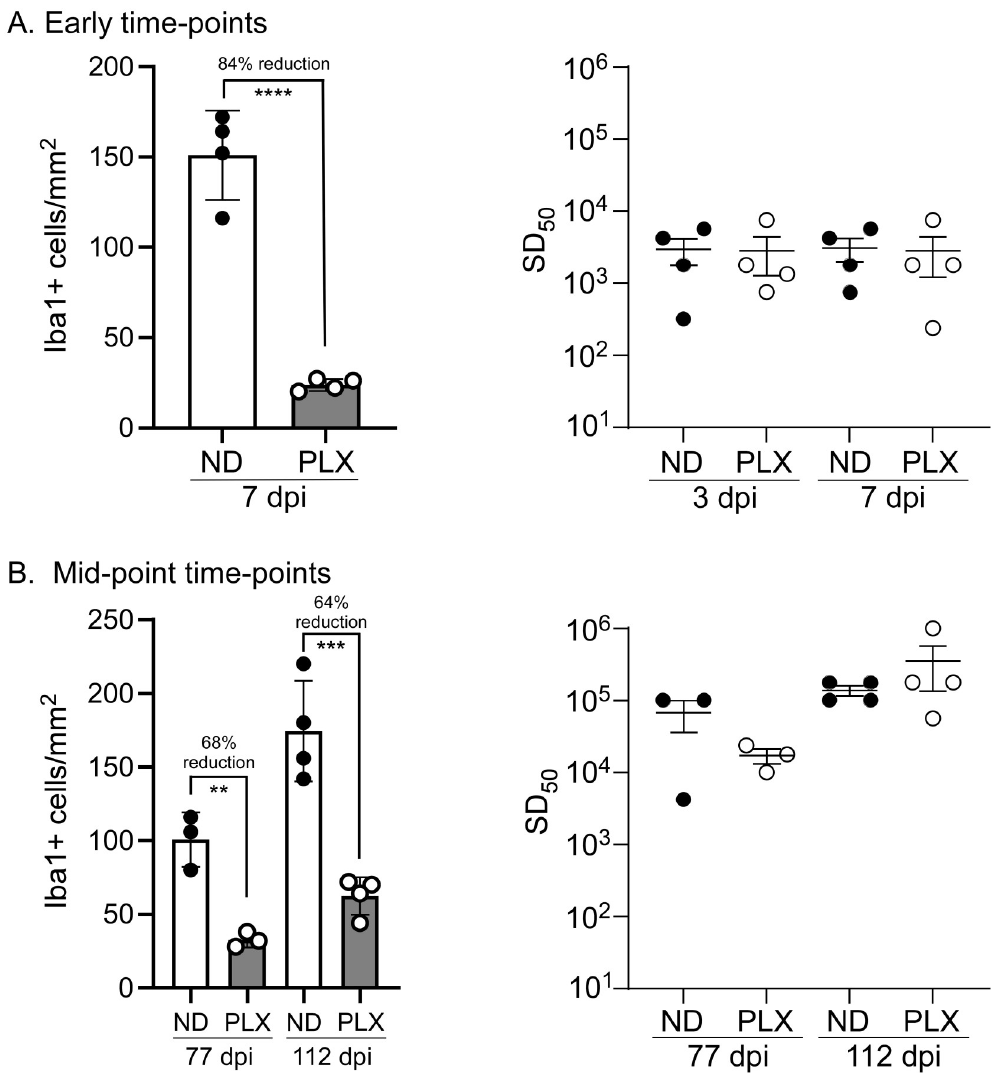
Fig 3. Microglial depletion and RT-QuIC seeding dose determination at mid-points of infection. Mice were treated with PLX5622 at day -7 and discontinued at day 3 or 7 (panel A) or discontinued at day 77 or 112 (panel B) when mice were euthanized for analysis. Sections of cortex were stained for Iba1, and positive cells were counted manually (panels A and B, left graphs). Solid circles indicate the number of Iba1+ cells in individual mice with no drug (ND) and the white column is the mean. Open circles indicate the number of Iba1+ cells in individual mice treated with PLX5622 (PLX) and the grey column indicates the mean. The bars in each column represent the standard deviation. �� indicates a P value � 0.01, ��� indicates a P value � 0.001, ���� indicates a P value � 0.0001. The RT-QuIC seeding dose 50 (SD 50 ) was assessed at early and mid-timepoints following 22L inoculation of untreated (ND, solid circles) and PLX5622 (PLX, open circles) treated mice (panels A and B, right graphs). Serial half-log dilutions were tested by RT-QuIC to determine a single SD 50 value for each mouse. No significant differences were measured between ND and PLX mouse groups at any individual time-point (unpaired